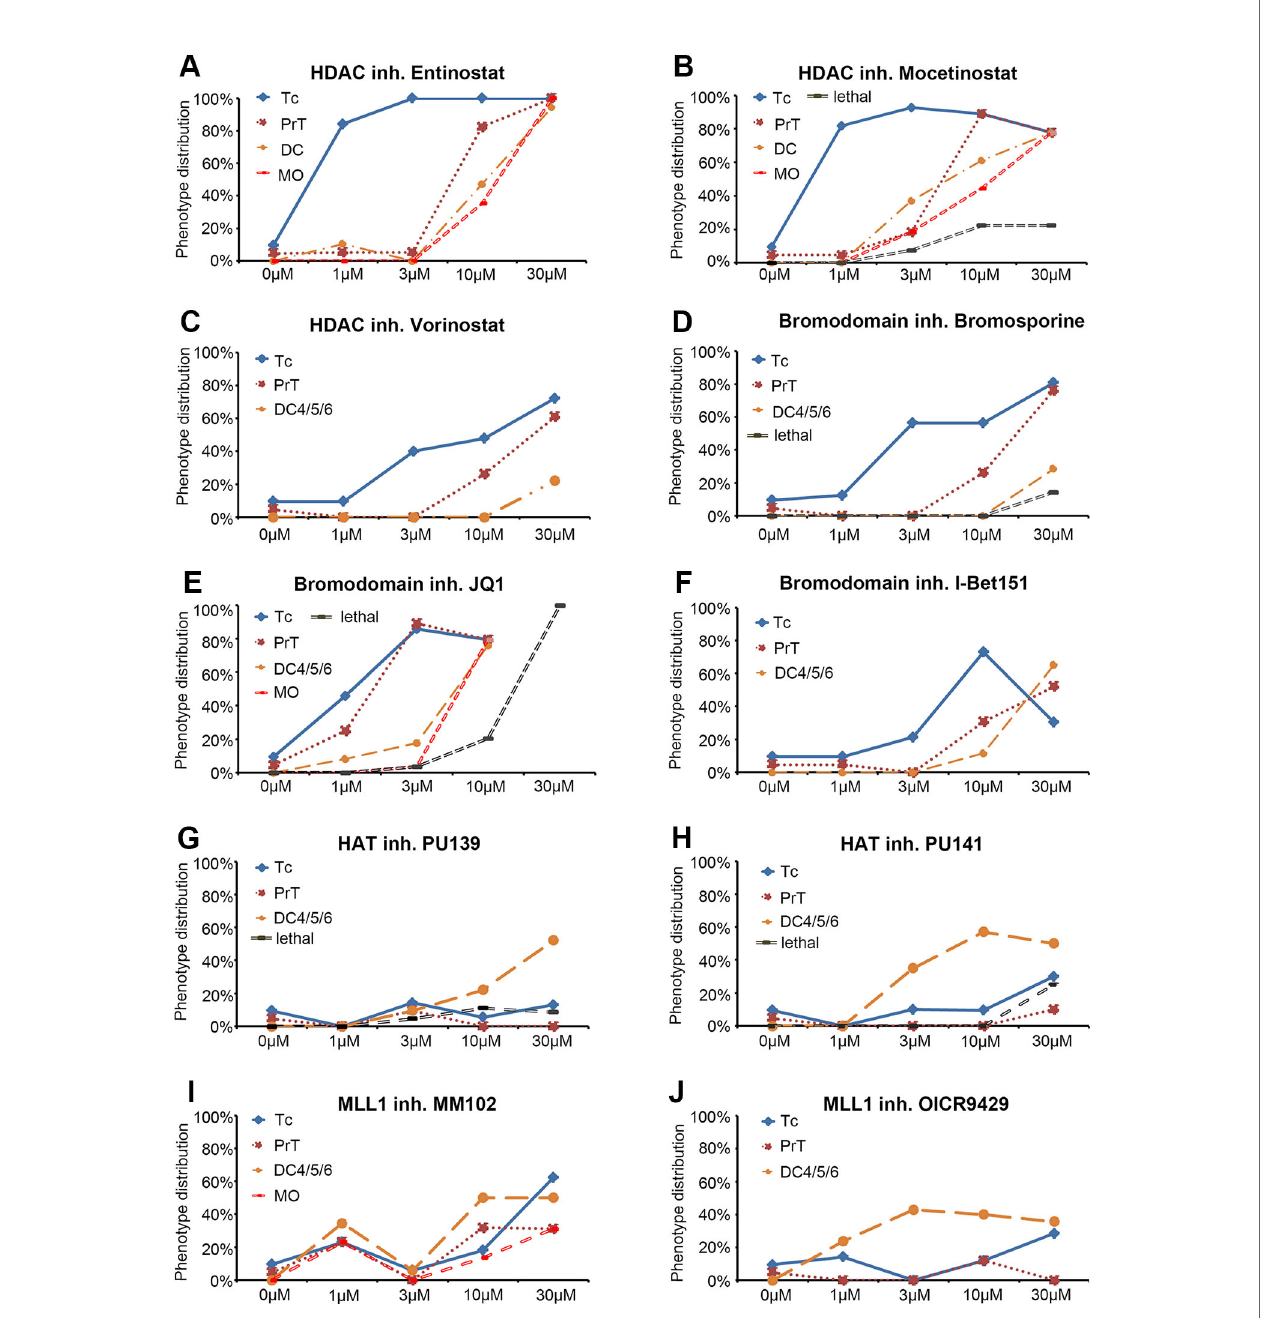
FIGURE 2 | Dose response curves for selected small molecule inhibitors. (A – J) Dose response curves for HDAC inhibitors (A) Entinostat, (B) Mocetinostat, (C) Vorinostat, for Bromodomain inhibitors (D) Bromosporine, (E) JQ1, (F) I Bet151, for HAT inhibitors (G) PU139, (H) PU141, and for MLL1-WDR5 interaction inhibitors (I) MM102 and (J) OICR9429. Each line represents a speci fi c DA or NA neuron cluster for which a change in th expression was observed. The black dashed line ( “ lethal ” ) indicates the percentage of embryos that died at a given compound concentration. Each data point represents the percentage of embryos showing an effect on the speci fi c neuron cluster at the depicted concentration. Abbreviations for dopaminergic clusters: Tc, telencephalon; PrT, pretectum; DC, diencephalic clusters 1 – 6; noradrenergic clusters; MO, medulla